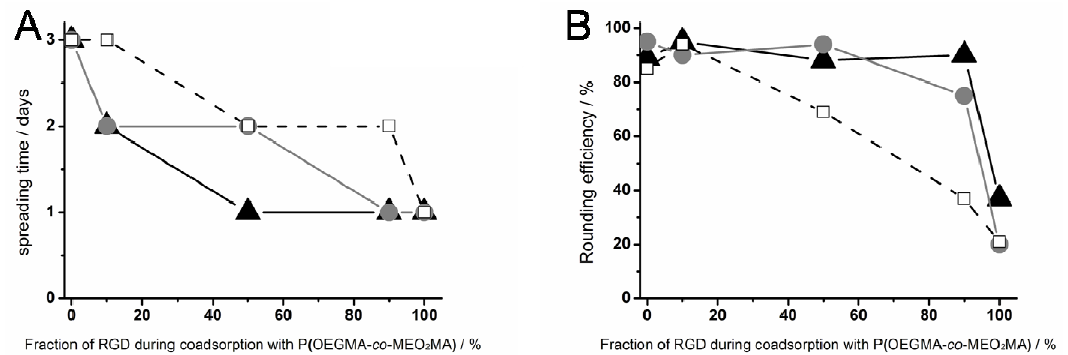
Figure 4. ( A ) Cell spreading time and ( B ) rounding efficiency of L929 mouse fibroblasts on different thermoresponsive substrates, produced by coadsorption of poly(MEO OEGMA) and varying ratios (abscissa) of RGD peptides: RGD with a short spacer of 0.4 nm (black triangles), OEG-RGD with an intermediate spacer of 1.8 nm (gray circles) and OEGMA-RGD with a long spacer of 4 nm (open squares). The numbers for the fraction of RGD represent the composition in the solution and not necessarily in the